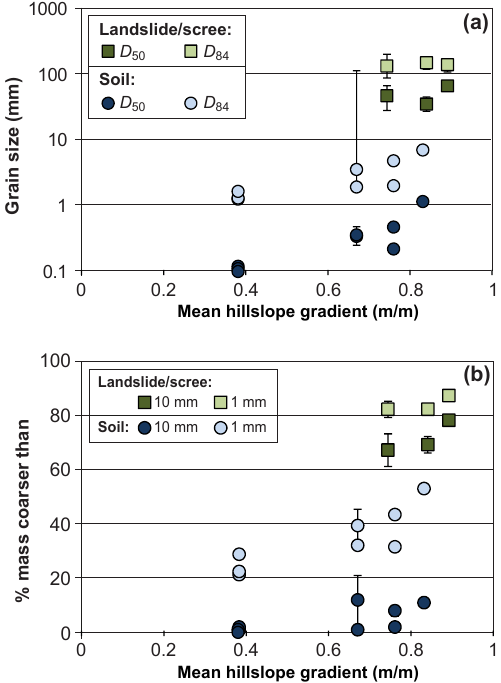
Figure 8. Grain size data for the sources of sediment: soils (circles) and landslides (squares). (a) Median grain size D 50 and 84th per- centile D 84 as a function of hillslope steepness. (b) Percent mass of the total sample finer than 1 and 10mm as a function of hills- lope steepness. Error bars represent plus or minus values calculated according to procedure described in Sect.